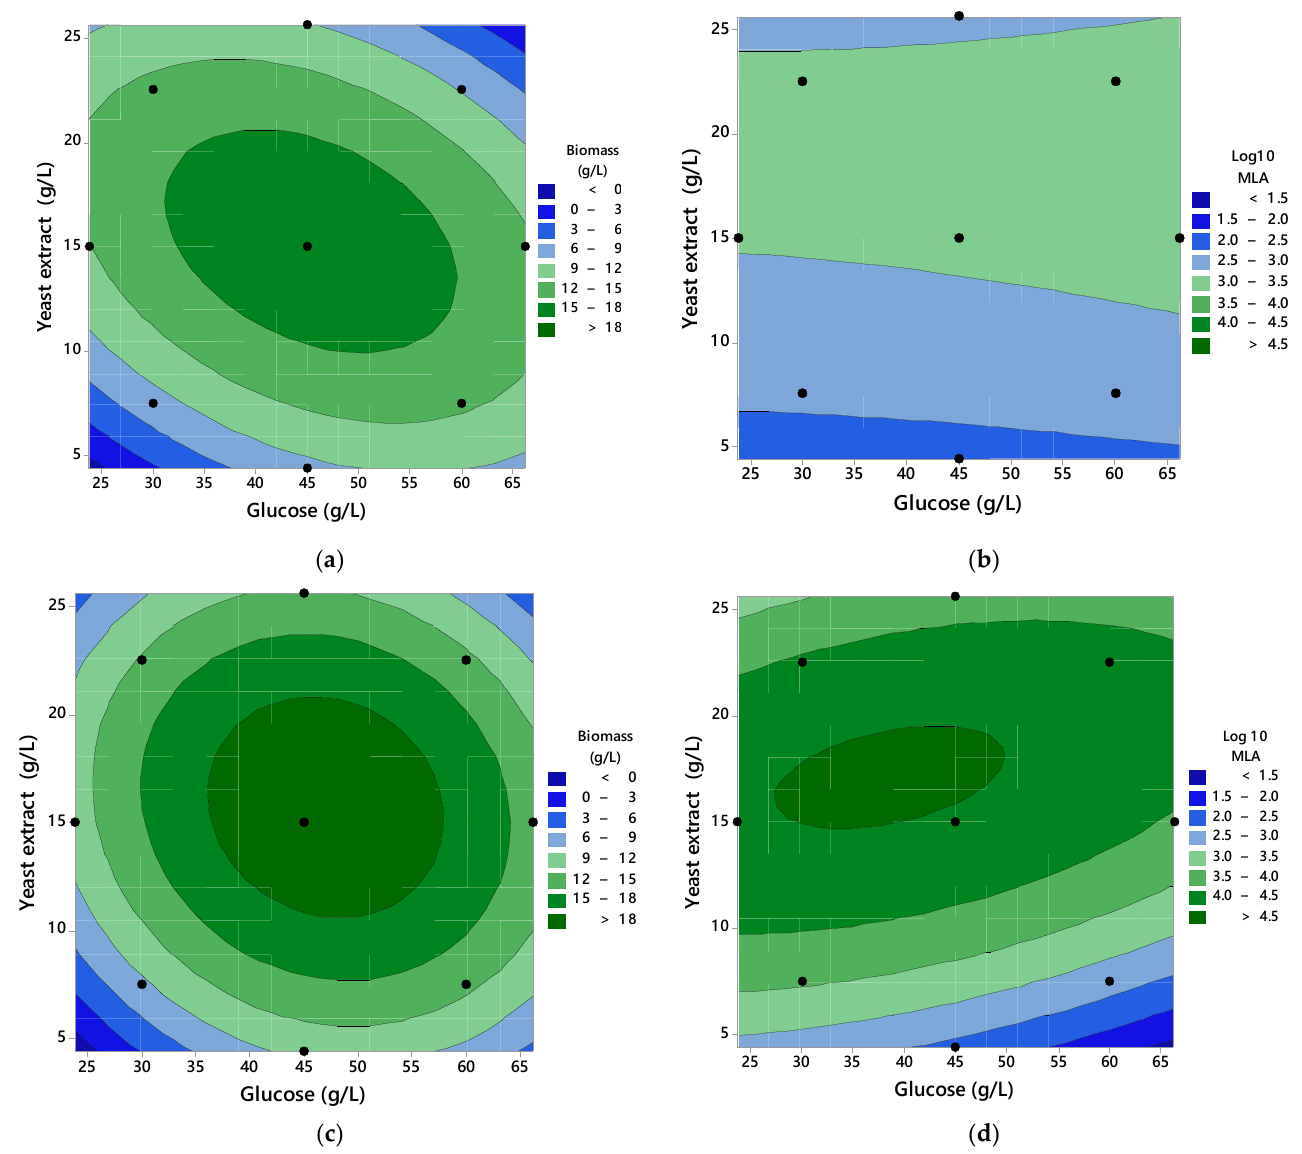
Figure 4. Contour plots of YE and glucose concentration vs. biomass and maximum laccase activity: ( a ) Biomass production in cultures without copper sulfate; ( b ) maximum laccase activity (MLA) as Log 10 MLA (UL − 1 ) production in cultures without copper sulfate; ( c ) biomass production in cultures with copper sulfate; ( d ) maximum laccase activity (MLA) as Log 10 MLA (UL − 1 ) production in cultures with copper